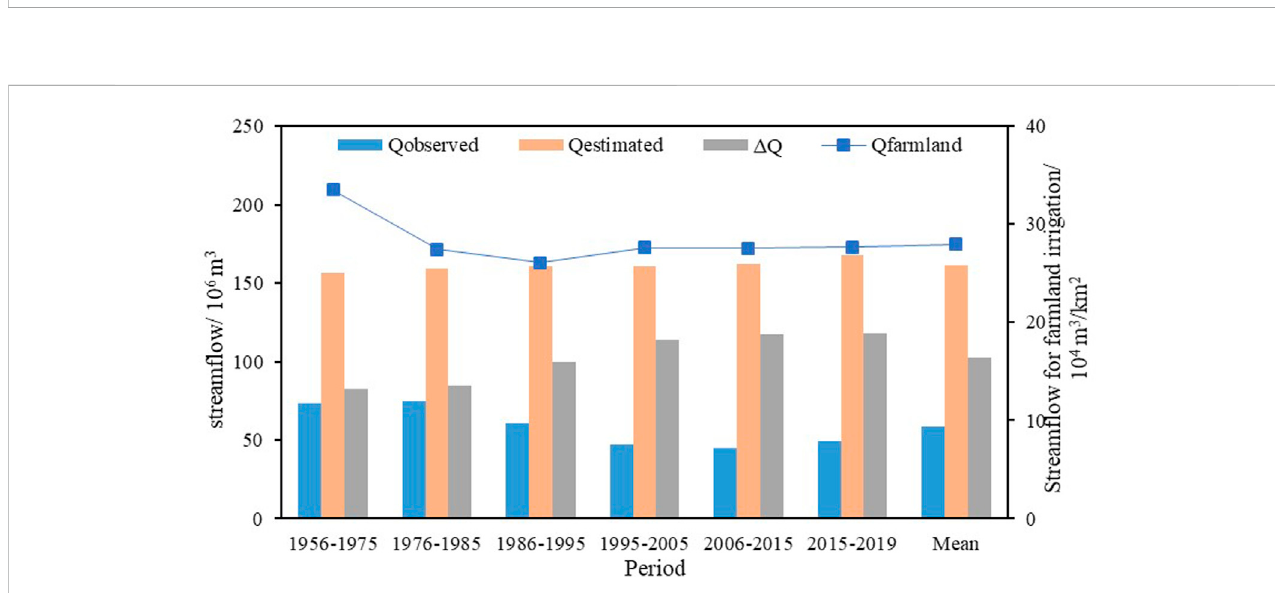
FIGURE 5 Differences ( Δ Q) between observed stream fl ow (Q observed ) and estimated stream fl ow (Q estimated ), and stream fl ow for farmland irrigation (Q farmland ) in various periods during 1956 – 2019 in the